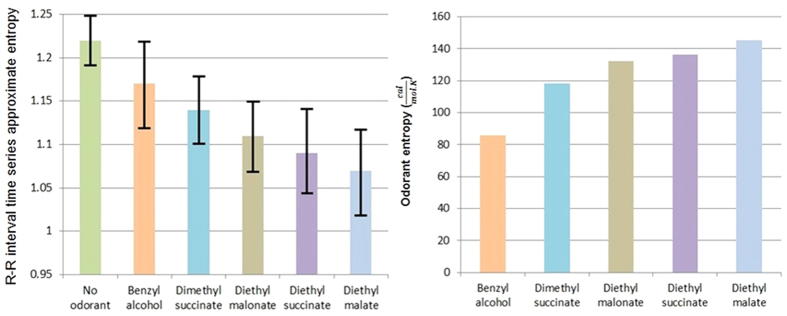
Approximate entropy for R-R interval time series due to different odorants (left side), and the odorants’ entropies (right side).Error bars indicate standard deviations.